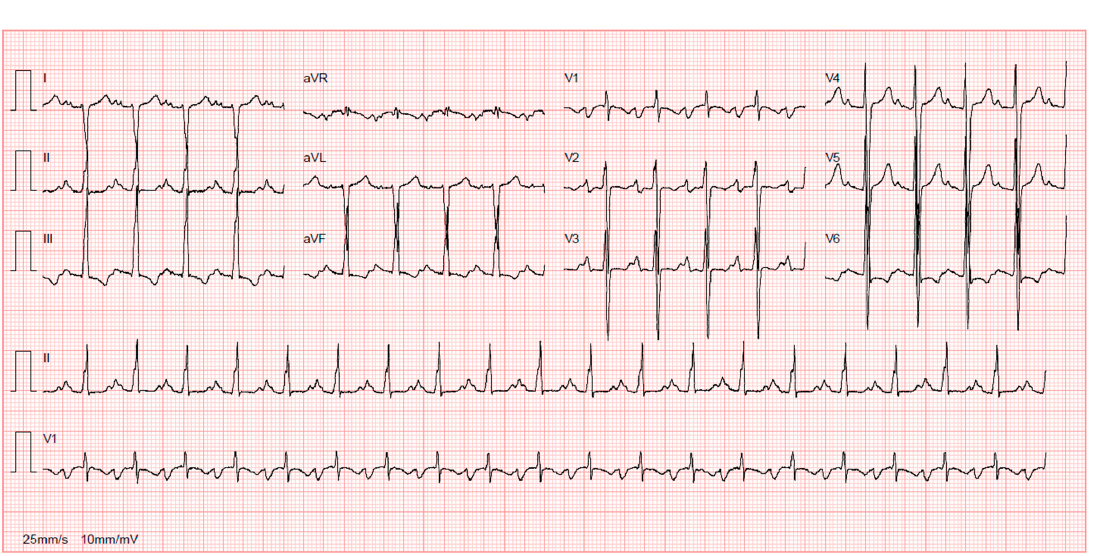
Figure 3. ECG of a 14-year-old girl with familial DCM showing sinus tachycardia, right axis deviation and nonspecific ST-wave changes.